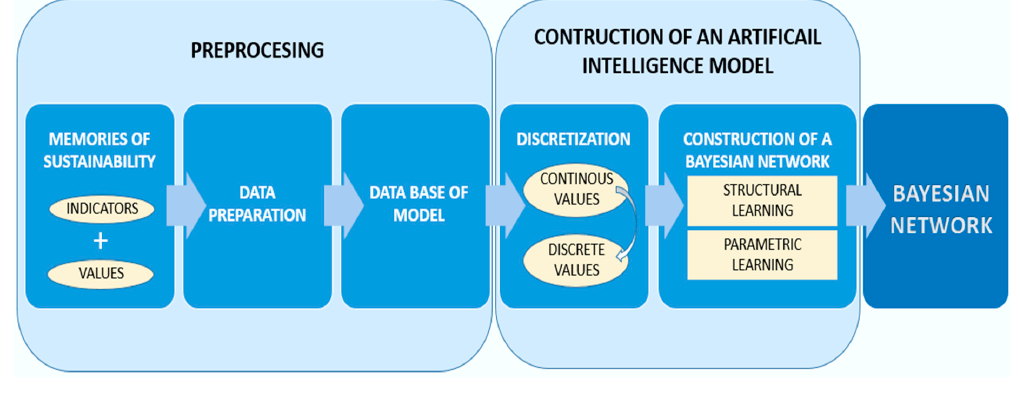
Figure 2. Process to construct a Bayesian network.